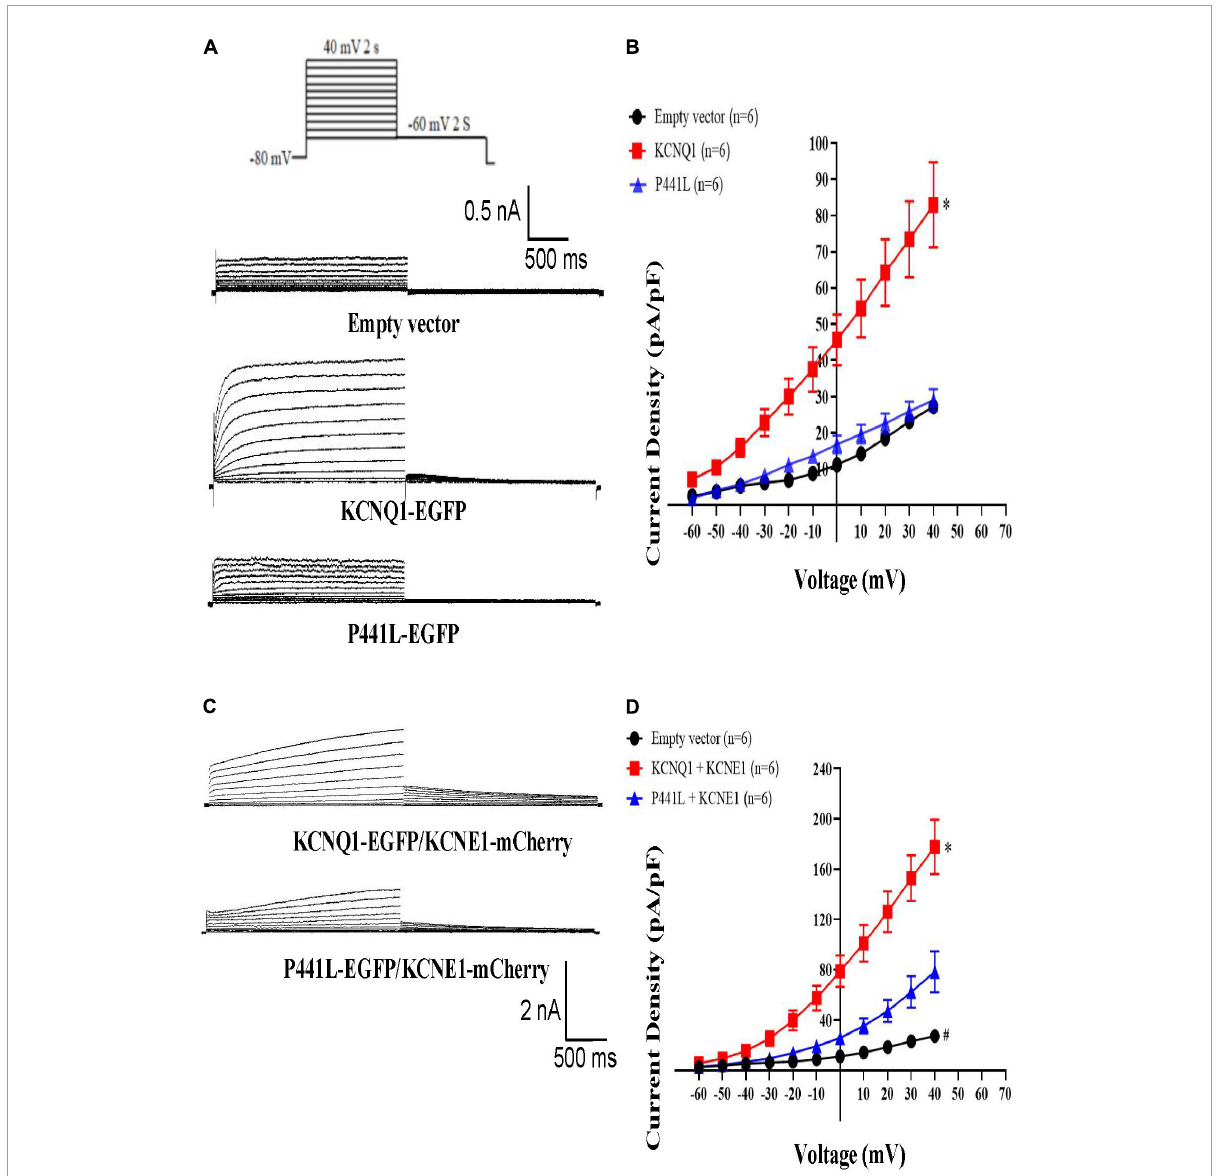
FIGURE3 Properties of KCNQ1 and P441L mutant whole-cell currents in HEK293 cells. (A) The 4-s test pulse voltage protocol (top) and representative current traces from HEK293 cells expressing empty vectors, KCNQ1-EGFP, or P441L-EGFP. (B) Summary data showing whole-cell current–voltage relationships of HEK293 cells expressing empty vectors, KCNQ1-EGFP, or P441L-EGFP. Data are shown as the mean ± SEM, n = 6, * P < 0.05 vs. KCNQ1-EGFP. (C) Representative current traces from HEK293 cells co-expressing KCNQ1-EGFP/KCNE1-mCherry or P441L-EGFP/KCNE1-mCherry. (D) Summary data showing whole-cell current–voltage relationships of HEK293 cells expressing empty vector, KCNQ1-EGFP/KCNE1-mCherry, or P441L-EGFP/KCNE1-mCherry. Data are shown as the mean ± SEM, n = 6, * P <